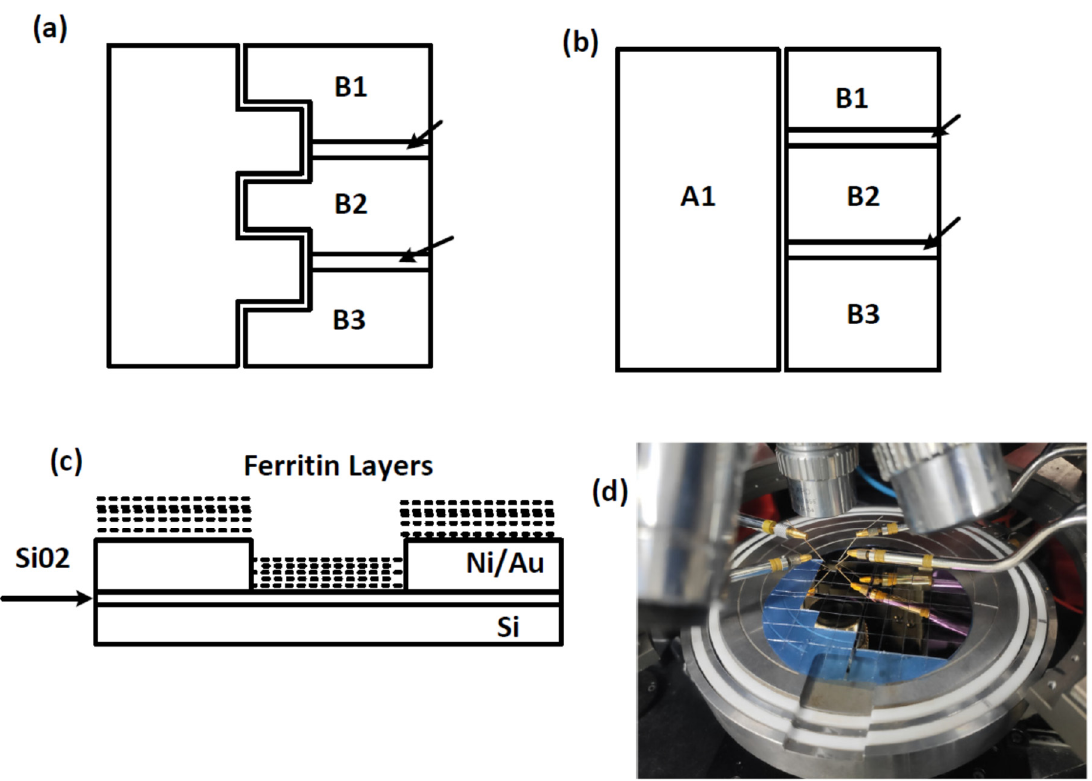
Figure 4. ( a ) Silicon die model 1; ( b ) silicon die model 2, ( c ) side view showing layer-by-layer deposition of ferritin; and ( d ) picture of test configuration.